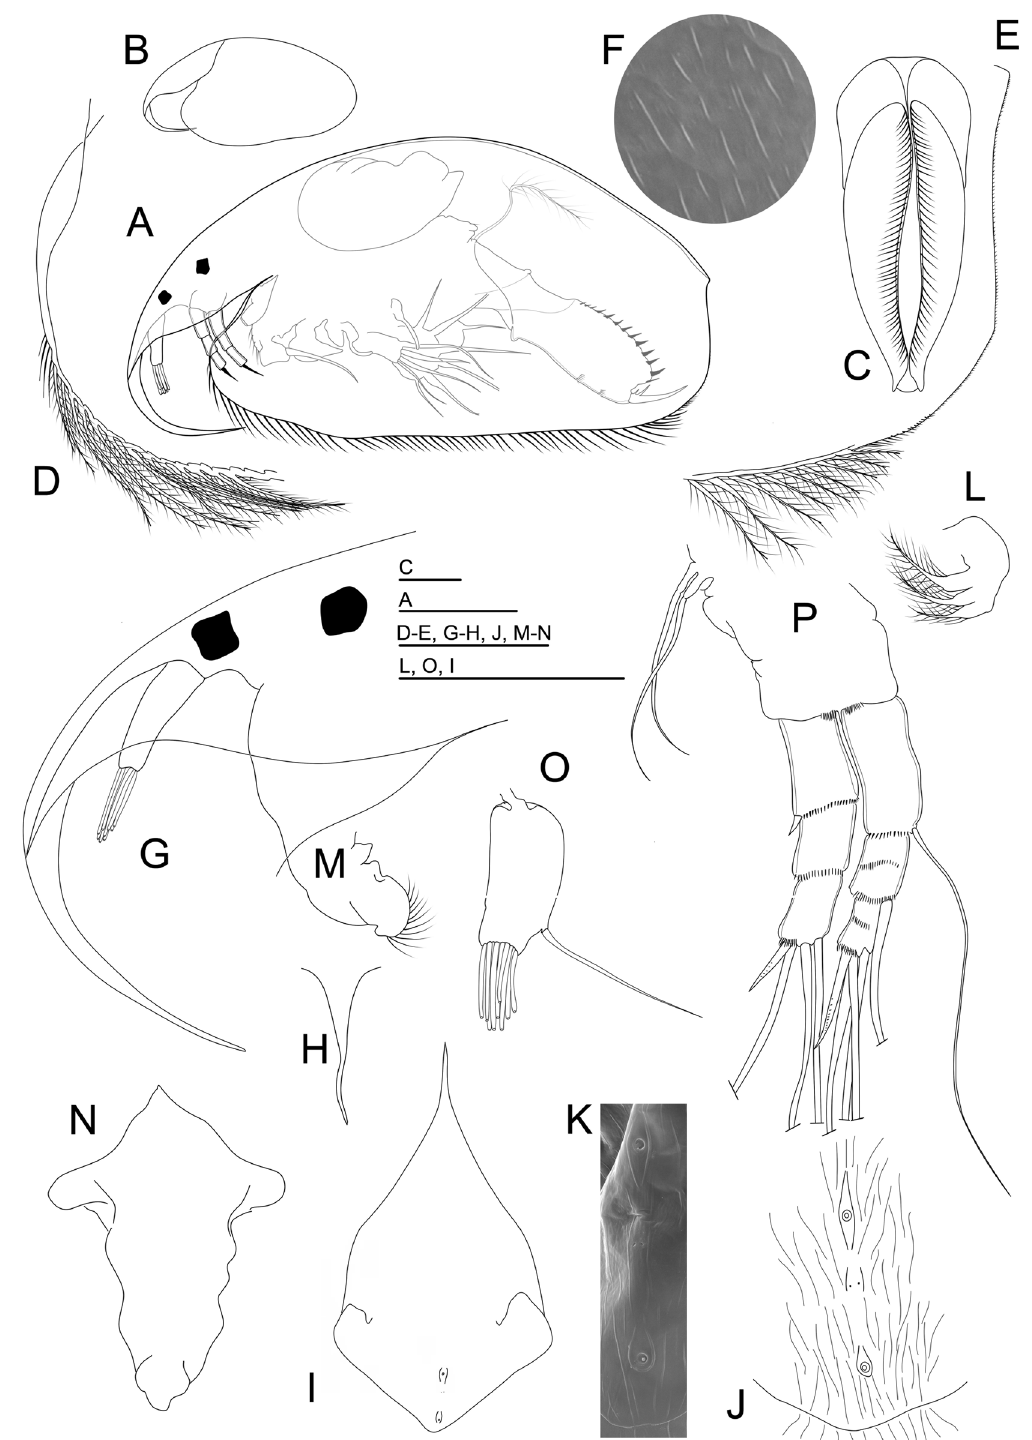
Fig. 1. Disparalona ( Mixopleuroxus ) leptorhyncha (Daday, 1905), parthenogenetic female. A–B . Habitus. C . Ventral view of carapace. D . Anterior portion of ventral margin of carapace. E . Posterior portion and posteroventral corner of carapace. F . Ornamentation of carapace. G . Rostrum. H . Idem , frontal view. I . Head shield. J–K . Main head pores. L . Maxilla. M . Labrum. N . Idem , frontal view. O . Antennule. P . Antenna. Scale bars: C–E, G–I, L–O = 50 μm; A = 80 μm. Figs B, D, F, K were not